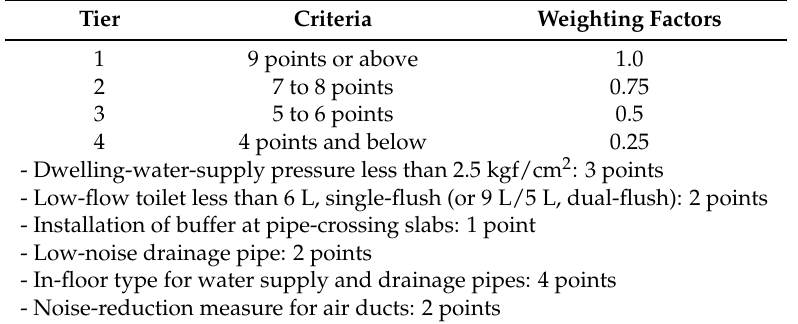
Table 2. Criteria and credits in G-SEED for measures to reduce water supply and drainage noises. Tier Criteria